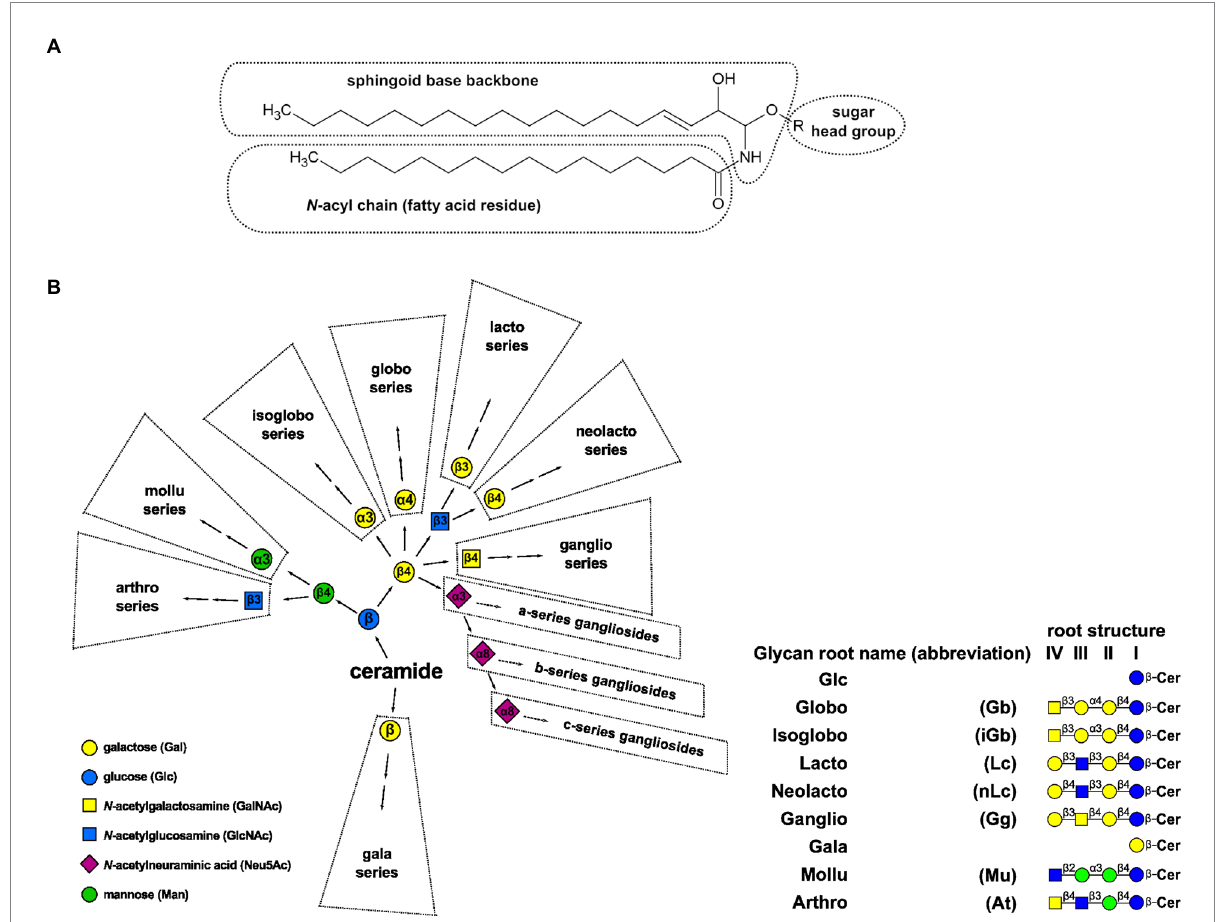
FIGURE 1 (A) Schematic representation of a GSL structure. Ceramide moiety comprises sphingoid backbone (based on sphingosine d18:1 Δ 4 ) and N-acyl chain. (B) A backbone relational depiction of major GSL synthesis pathways and an overview of glycan root structures. Names and symbols